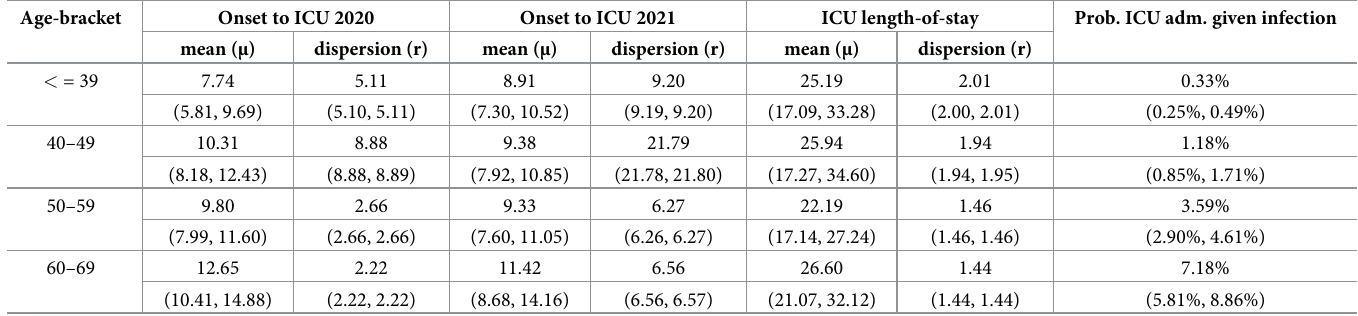
Table 3. Estimates for parameters of the onset-to-ICU interval and ICU length-of-stay distributions by age bracket. Estimates for the mean ( μ ) and dispersion (r) parameters of the negative binomial distribution for onset-to-ICU interval and ICU length-of-stay time periods, and for the probability of ICU admission conditional to infection. Brackets indicated 95% confidence